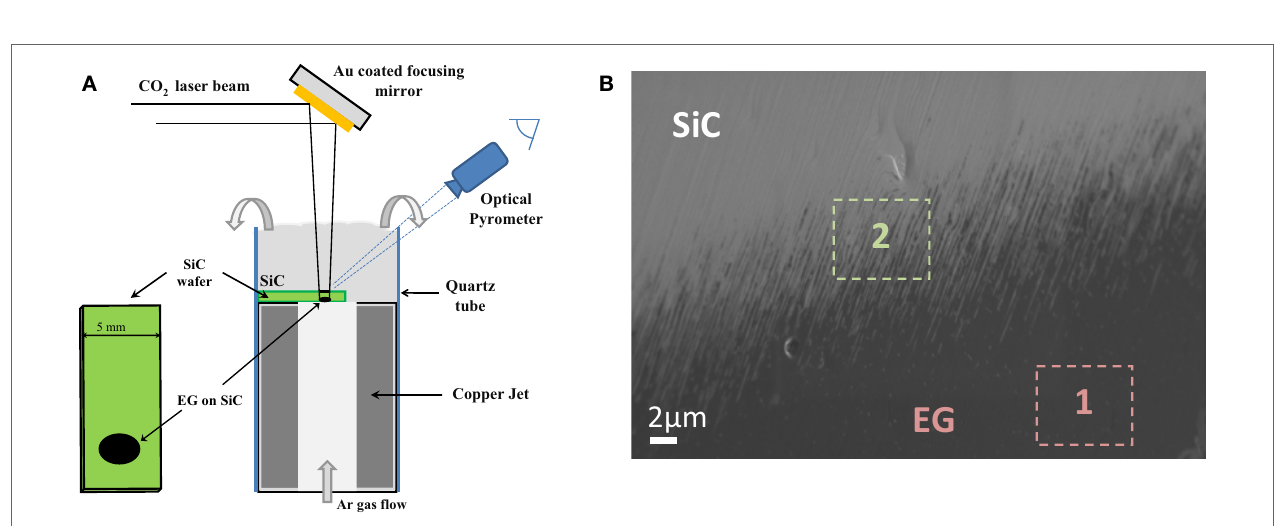
FiGURe 5 | Different configurations used for the flame synthesis of graphene, (A) dual flame configuration, (B) multiple inverse diffusion flames, (C) flame spray pyrolysis and (D) microcombustor . Reproduced with permissions from Luechinger et al. (2008), Li et al. (2011b), Memon et al. (2011), and Kellie et al. (2013).